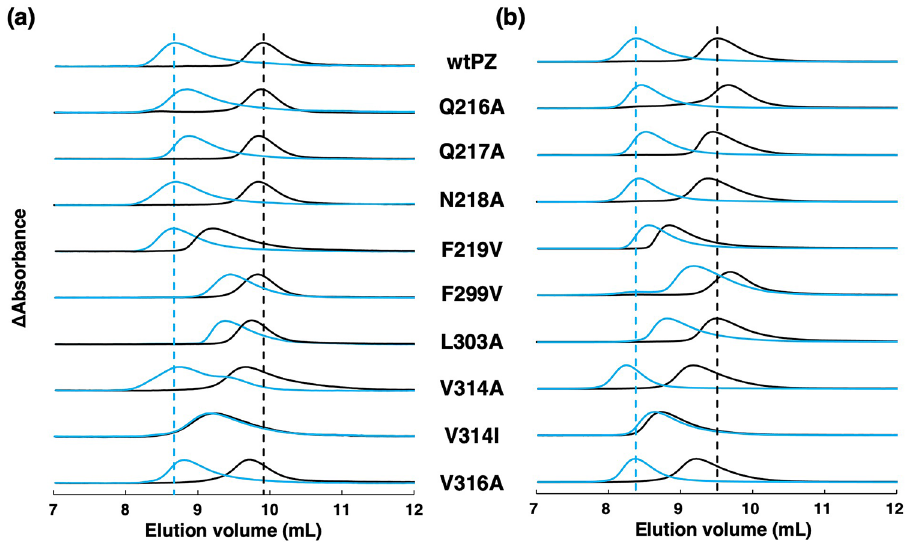
Figure 3. Elution profiles of wtPZ and PZ mutants monitored at 280 nm and at injected protein concentration of ( a ) 8 µM or ( b ) 50 µM. Black and blue lines indicate the profiles normalized to the maximum absorbance in the D and L states, respectively. Black and blue dashed vertical lines indicate the peak volumes of wtPZ in the D and L states,